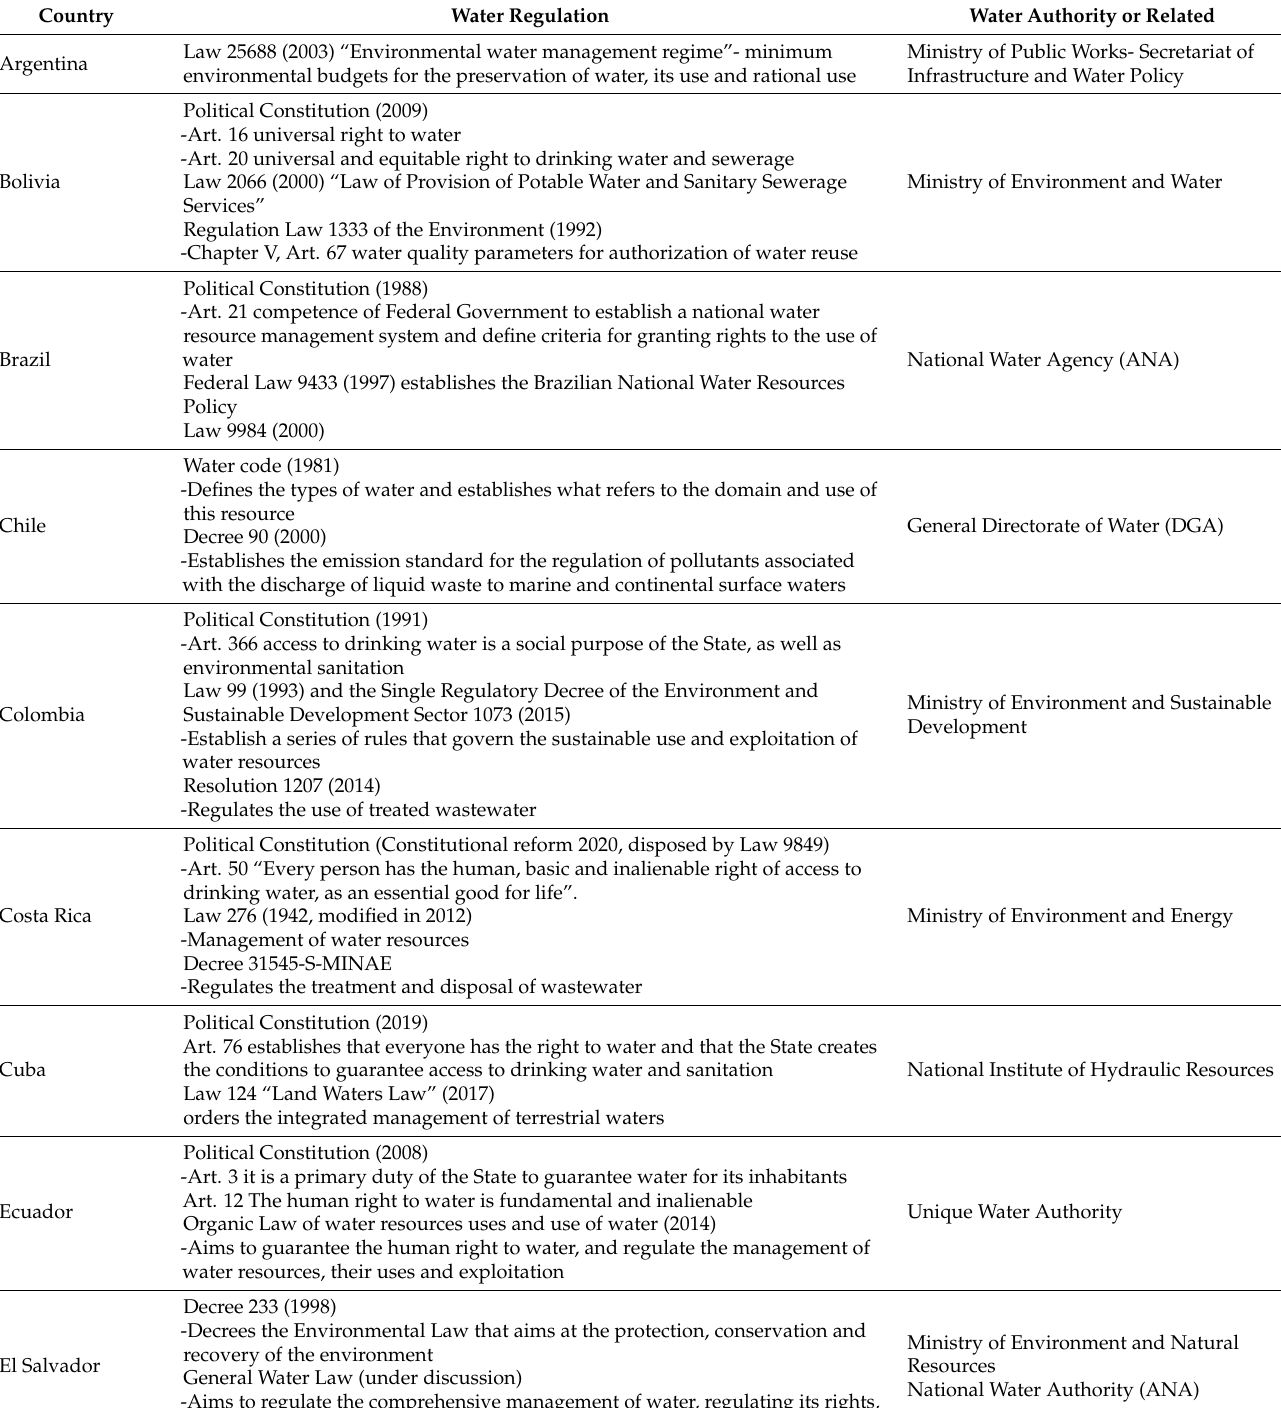
Table 2. Legislative framework on water matters in Latin America and the Caribbean and main authorities related to the institutional and administrative framework of water